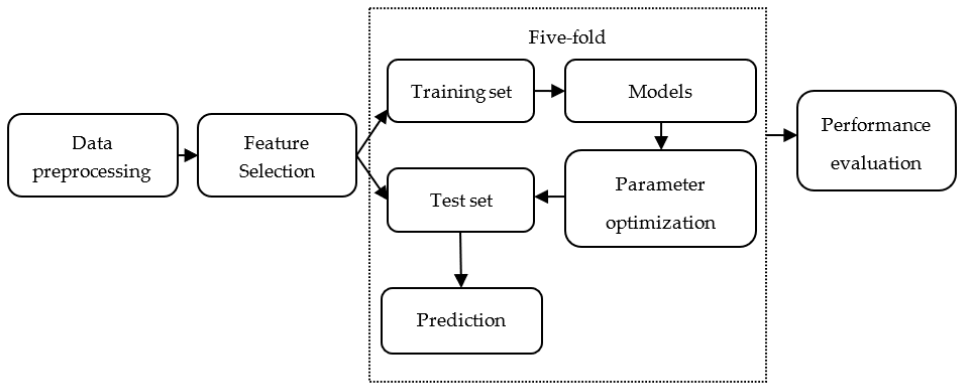
Figure 1. Machine learning